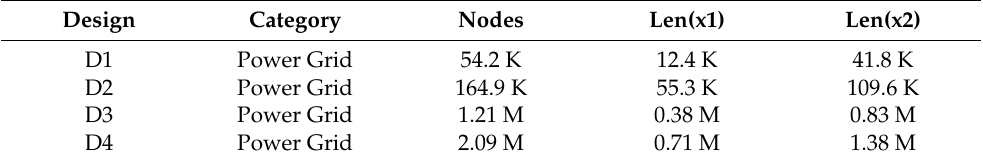
Table 1. Specifications of benchmark